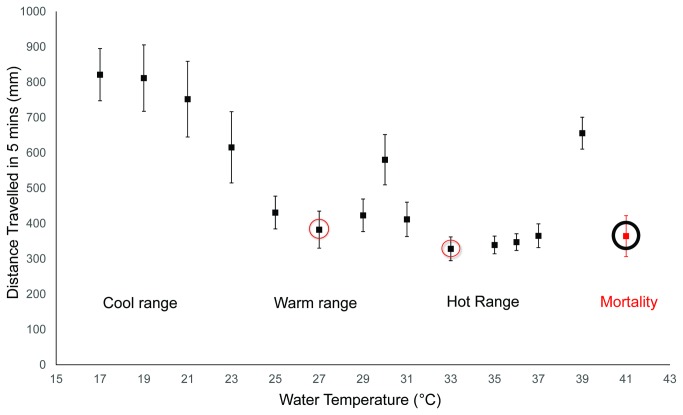
Thermal-induced mobility in WT 4th instar An.
gambiae larvae. Arithmetic means ± standard error of the mean (S.E.M) of total distance travelled by individual larva in 300s were plotted (n≥15). Red circle indicates the two individual temperatures that generated lowest larval mobility in the neighboring temperature ranges (27 and 33°C) while black circle shows the temperature at which larvae experienced morbidity/death after 2-3 mins of assaying (41° C), thus the total distance was calculated based on the time frame before larval mortality.